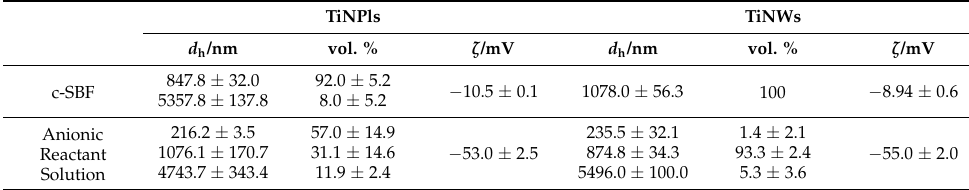
Table 1. Hydrodynamic diameter ( d h ) and zeta potential ( ζ ) of TiO 2 nanoplates (TiNPls) and nanowires (TiNWs) suspended in corrected simulated body fluid (c-SBF) and anionic